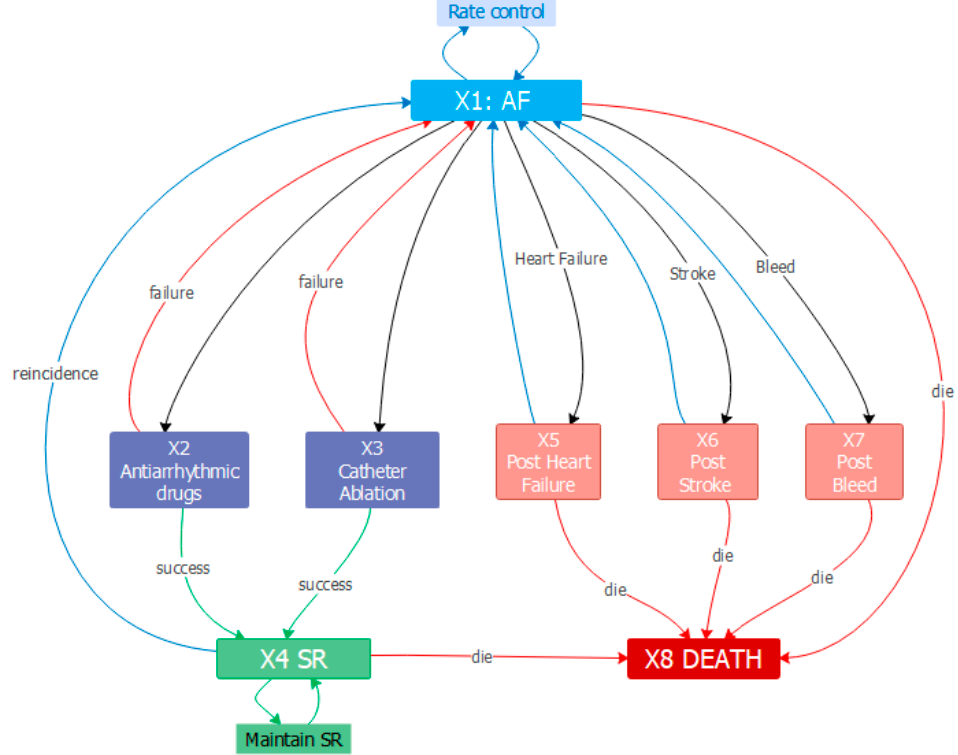
Figure 1. Model state diagram. States and transitions. Source: prepared by the authors.